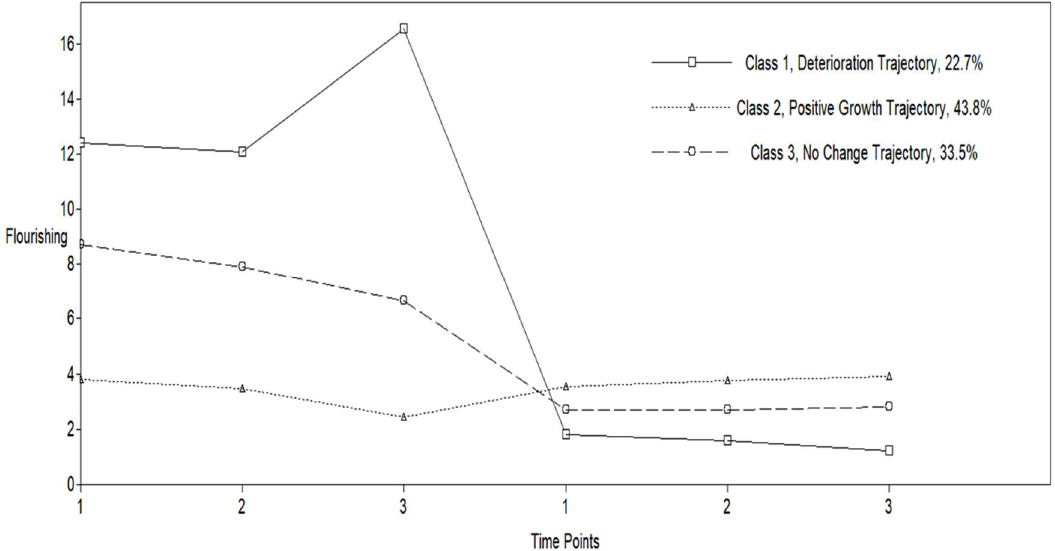
Figure 1. Plot of growth curves for the unconditional 3-class solution. Note: first line segment = depression, second line segment = well-being. Class 1: intercept 1 = 12.06, SE = 0.86, p < 0.001, slope 1 = 0.49, SE = 0.18, p = 0.01, intercept 2 = 1.79, SE = 0.07, p < 0.001, slope 2 = −0.07, SE = 0.03, p = 0.01. Class 2: intercept 1 = 3.87, SE = 0.42, p < 0.001, slope 1 = −0.20, SE = 0.08, p = 0.01, d = 0.45, intercept 2 = 3.56, SE = 0.02, p < 0.001, slope 2 = 0.06, SE = 0.02, p < 0.001, d = 0.73. Class 3: intercept1 = 8.71, SE = 0.87, p < 0.001, slope 1 = −0.28, SE = 0.18, p = 0.11, intercept 2 = 2.70, SE = 0.12, p < 0.001, slope 2 = 0.003, SE = 0.03, p = 0.91. d = Cohen’s mean difference for repeated measures.